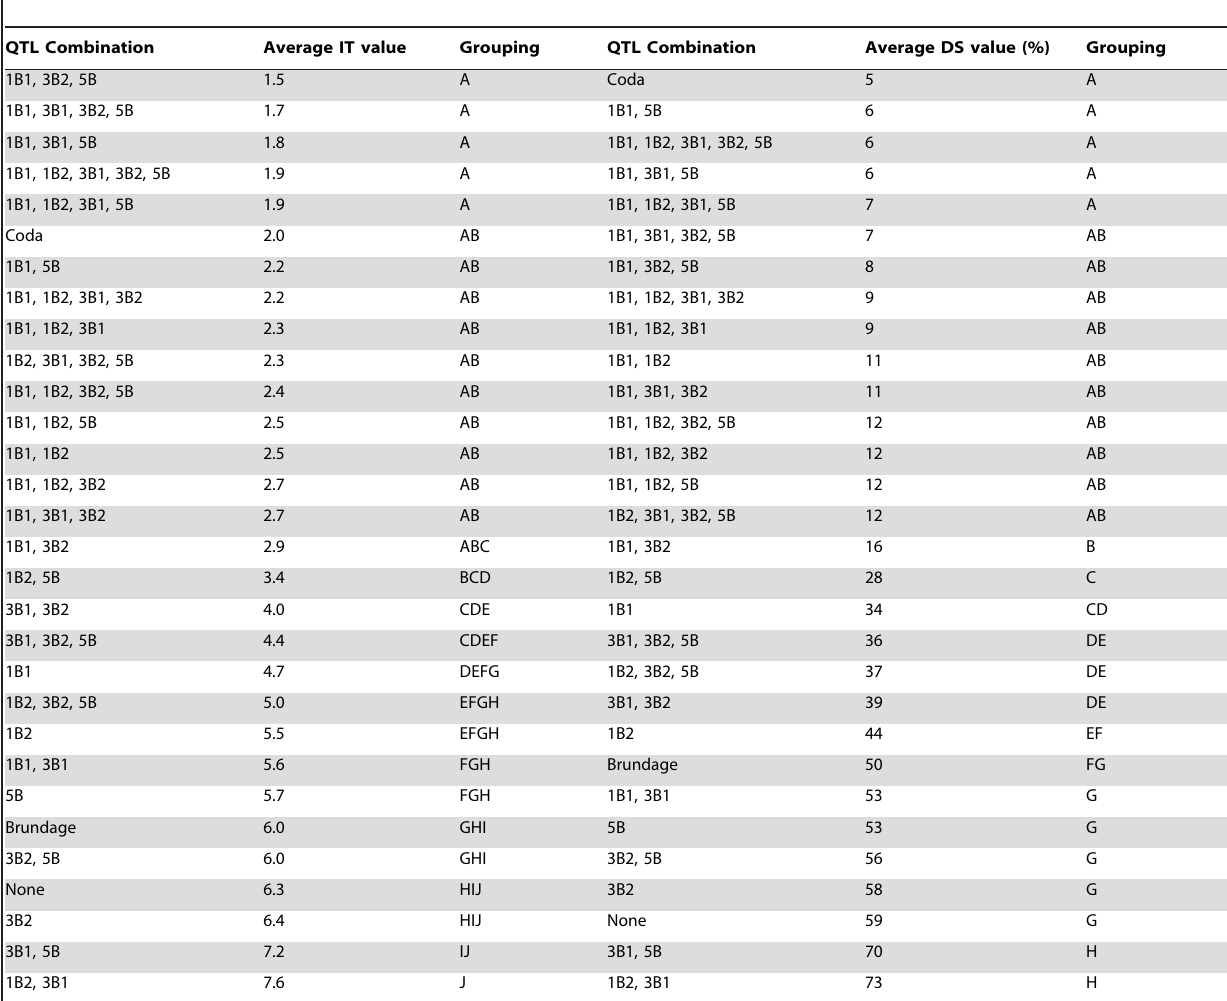
Letters above columns indicate Tukey’s mean separation groupings of mean (averaged over all reps within a location) IT and DS values for RIL possessing different QTL for stripe rust resistance. QTL symbols are: QYrco.wpg-1B.1 (1B1); QYrco.wpg-1B.2 (1B2); QYrbr.wpg-3B.1 (3B1); QYrbr.wpg-3B.2 (3B2); QYrco.wpg-5B (5B); no resistance QTL (None); the susceptible parent (Brundage); and the resistant parent (Coda).